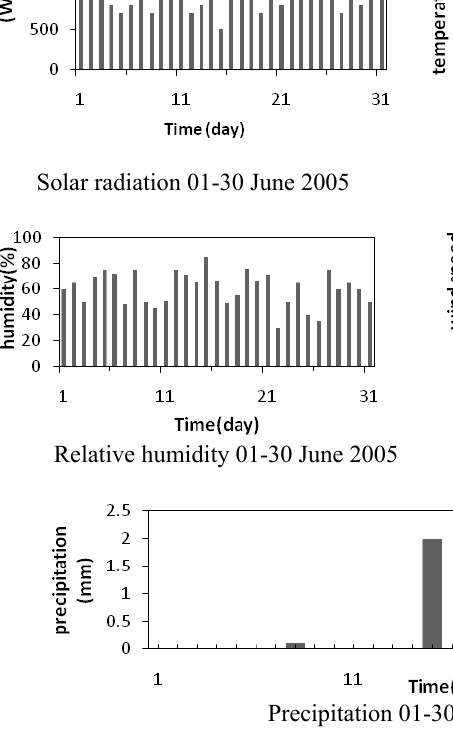
Figure 6. Atmospheric condition used in the case study Fig. 6. Atmospheric condition used in the case study (Recorded in June 2005 in the South of (Recorded in June 2005 in the south of Syria)